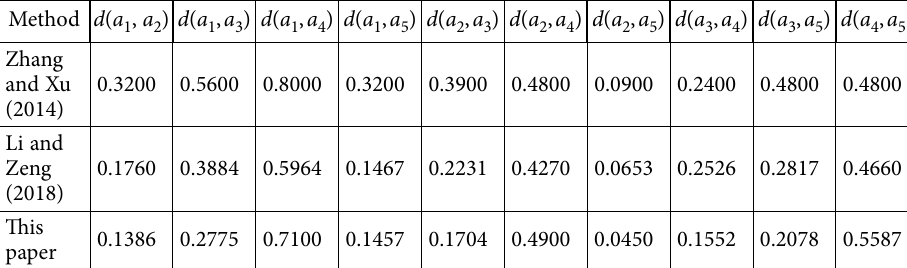
Table 2. Calculation results of the Euclidean distances between PFNs